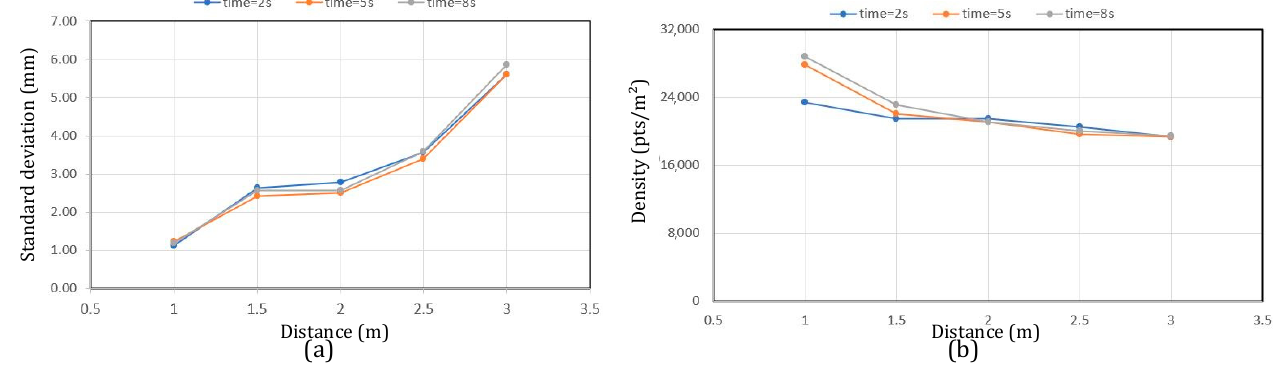
Figure 9. ( a ) Standard deviation of noise as a function of time and distance. ( b ) Density of points (points/m 2 ) as a function of time and distance.